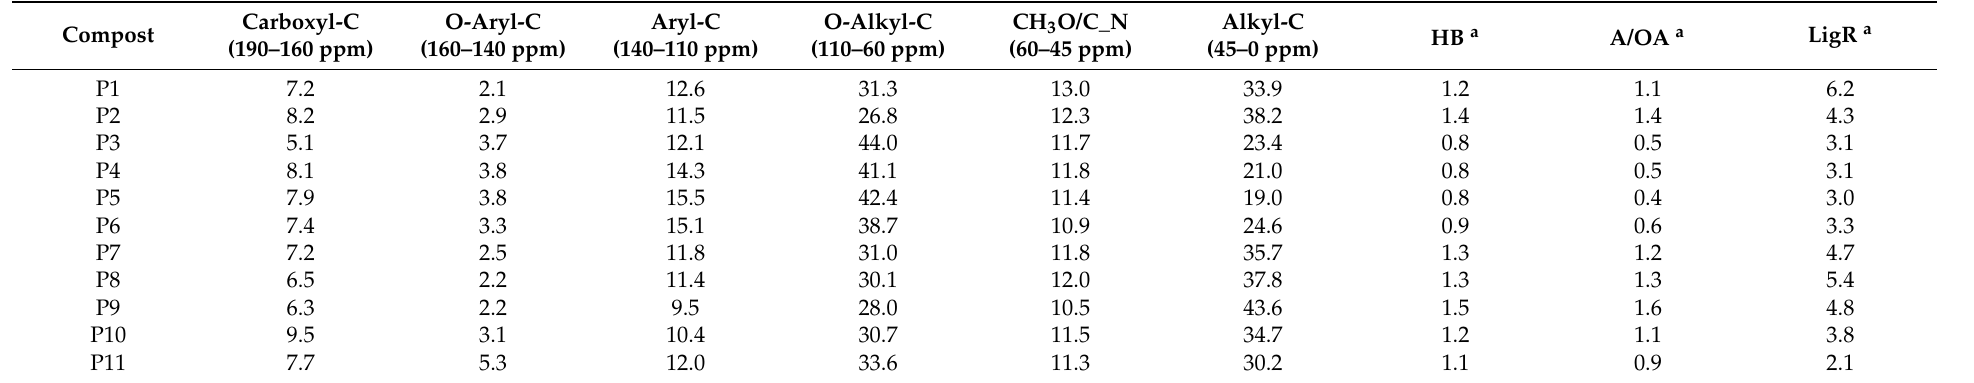
Table 4. Relative C distribution (%) over the chemical shift regions (ppm) and structural index in the NMR spectra of compost samples